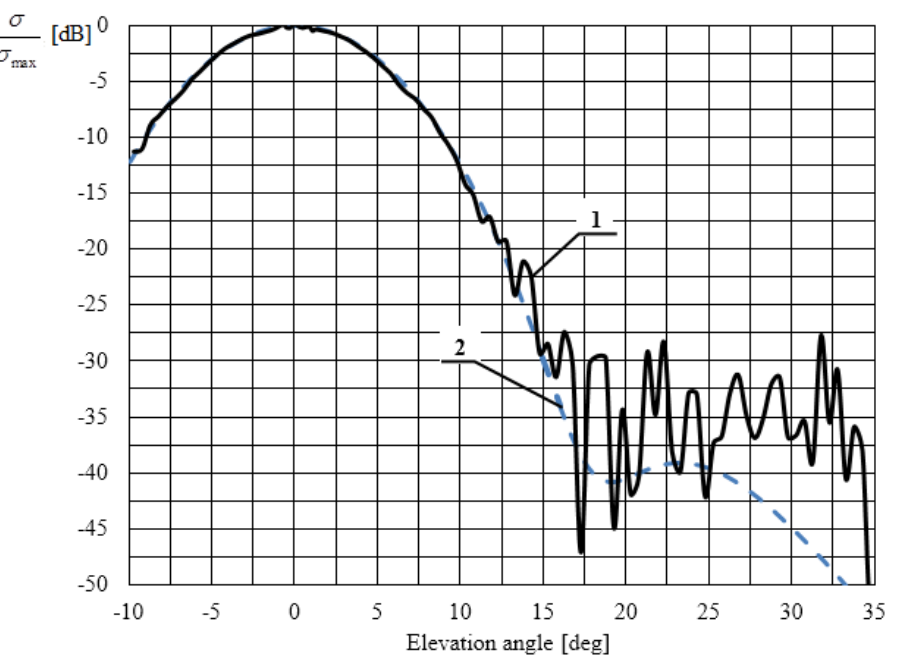
Fig. 8. Normalized H-plane monostatic modulation RCS at frequency f 0 : 1 – experimental; 2 –